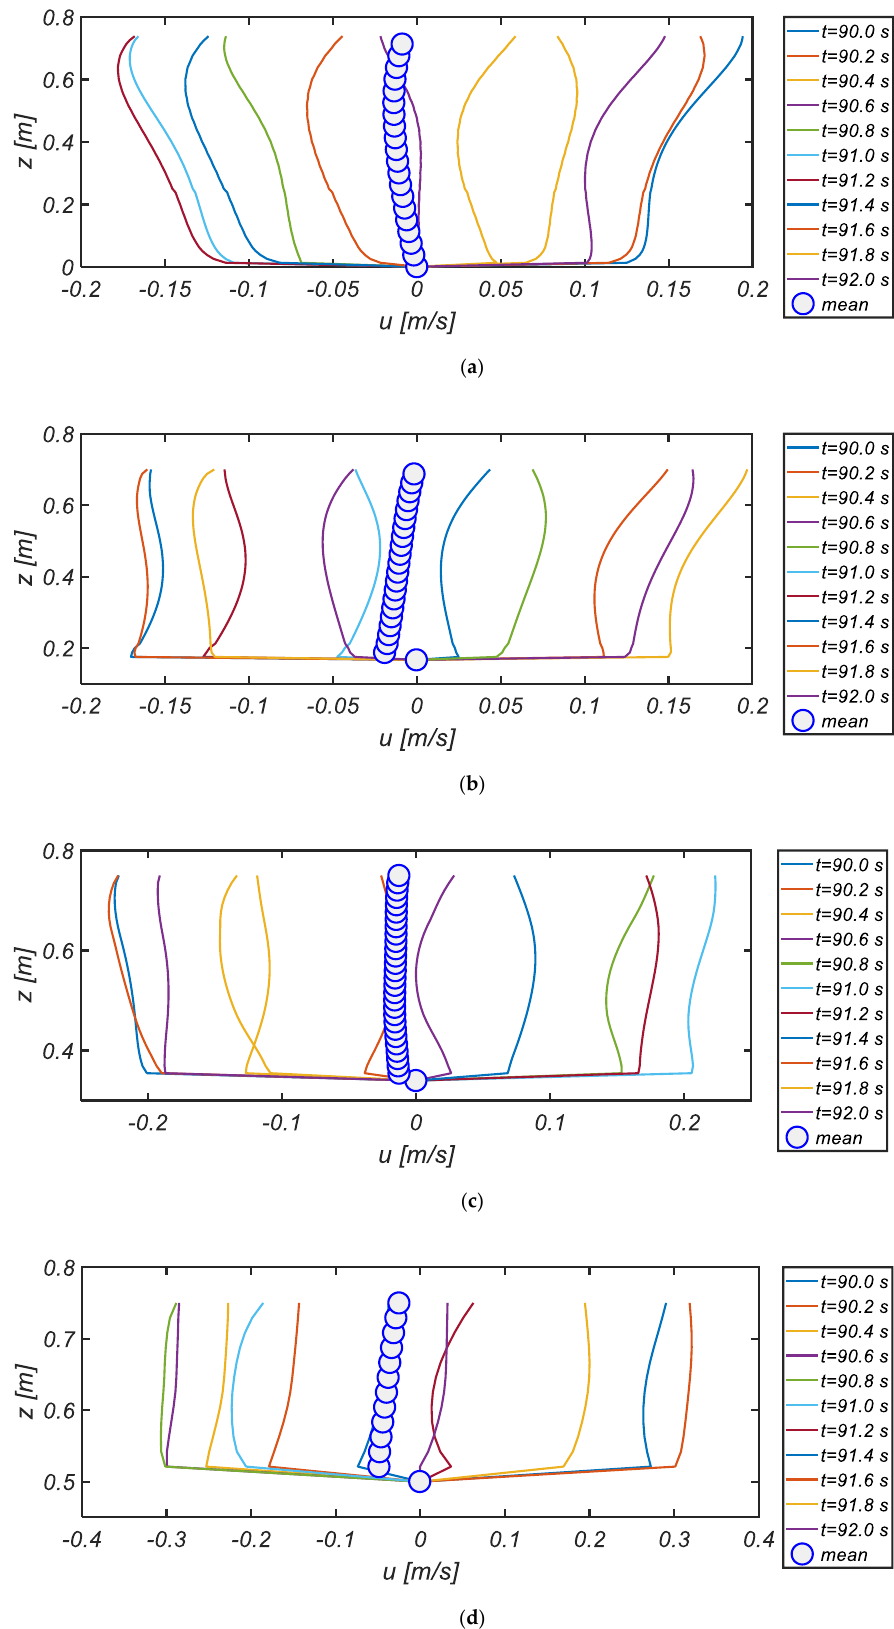
Figure 7. Temporal variation of the vertical profiles of horizontal velocity at Gauge No. 1, 2, 3, and 5 during unit wave period. ( a ) at Gauge NO. 1; ( b ) at Gauge NO. 2; ( c ) at Gauge NO. 3; ( d ) at Gauge NO.